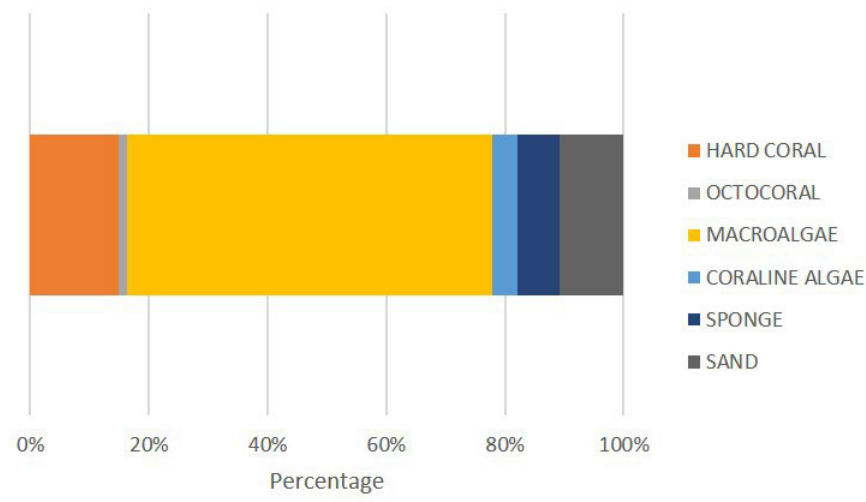
Figure 6. Benthic assemblage composition (%) by group in the mesophotic zone of Marine Protected Area Costa dos Corais, Brazil. EAM, zoanthids, bare rock, sea urchin, and crionidea were not recorded in the transects or other methodologies.